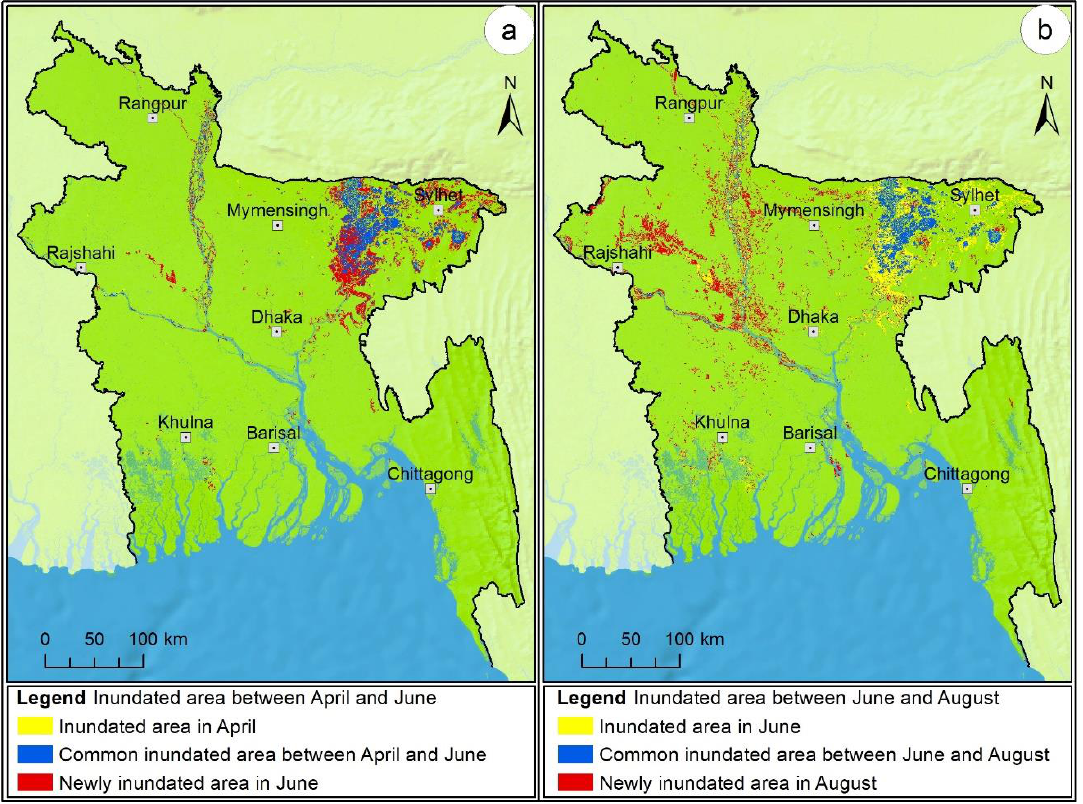
Figure 8. Flood recession and rise areas of Bangladesh between ( a ) April and June, ( b ) June and August. Table 2. Error matrix for the land cover map of 2017.